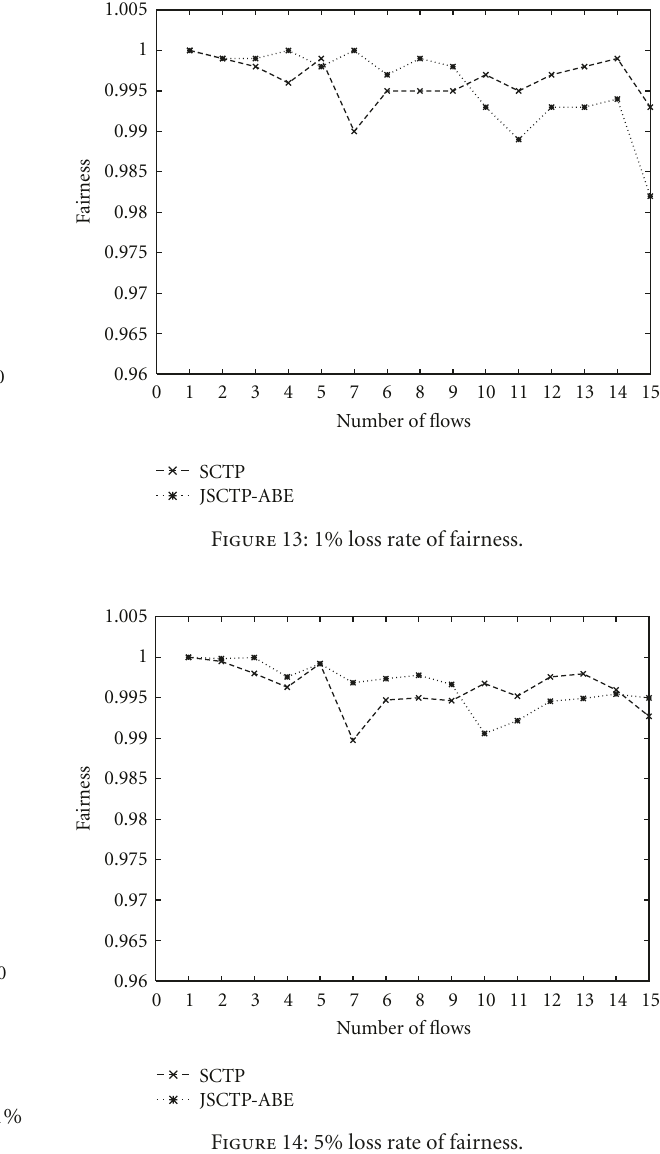
Figure 14: 5% loss rate of